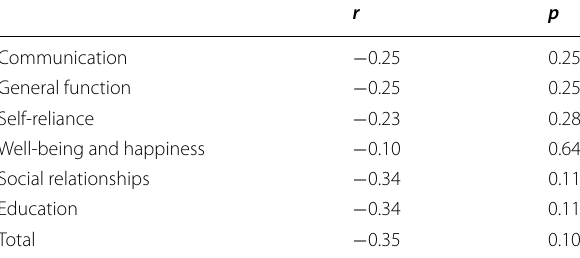
Table 6 Pearson correlation coefficient correlation between aided PTA threshold and PVECIQ-Arabic version domains, showing no statistically significant